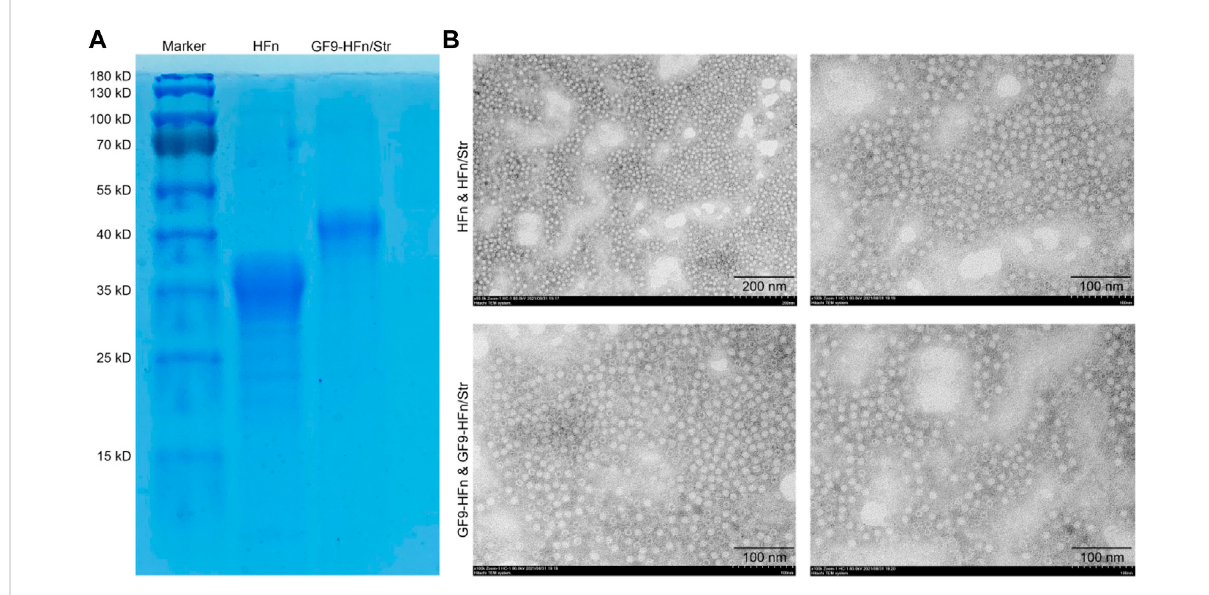
FIGURE 1 The evaluation of ferritin-based co-delivery nanomedicine. (A) SDS-PAGE evaluated the size of ferritin-based nanomedicine. (B) The morphology of nanomedicine was observed under TEM. SDS-PAGE, sodium dodecyl sulfate-polyacrylamide gel electrophoresis. TEM, transmission electron